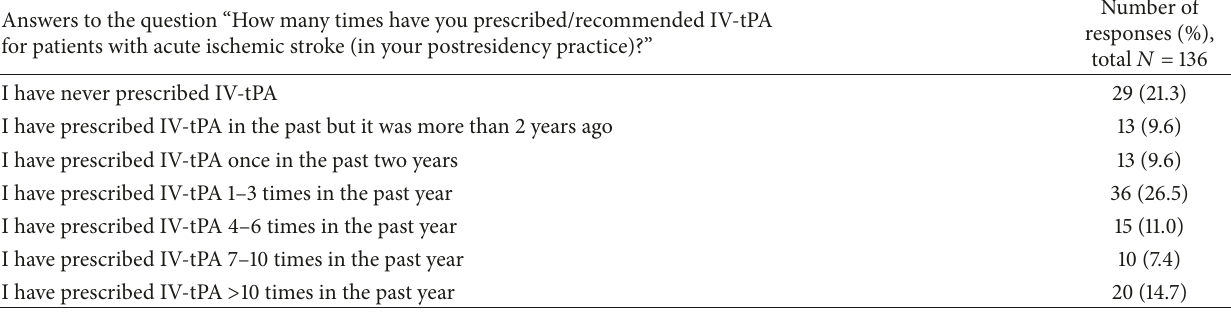
Table 1: Frequency of intravenous tissue plasminogen activator (IV-tPA) administration.